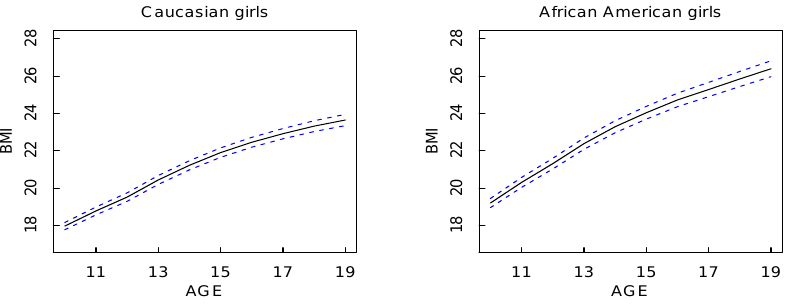
Figure 3. The estimated mean curves of girls’